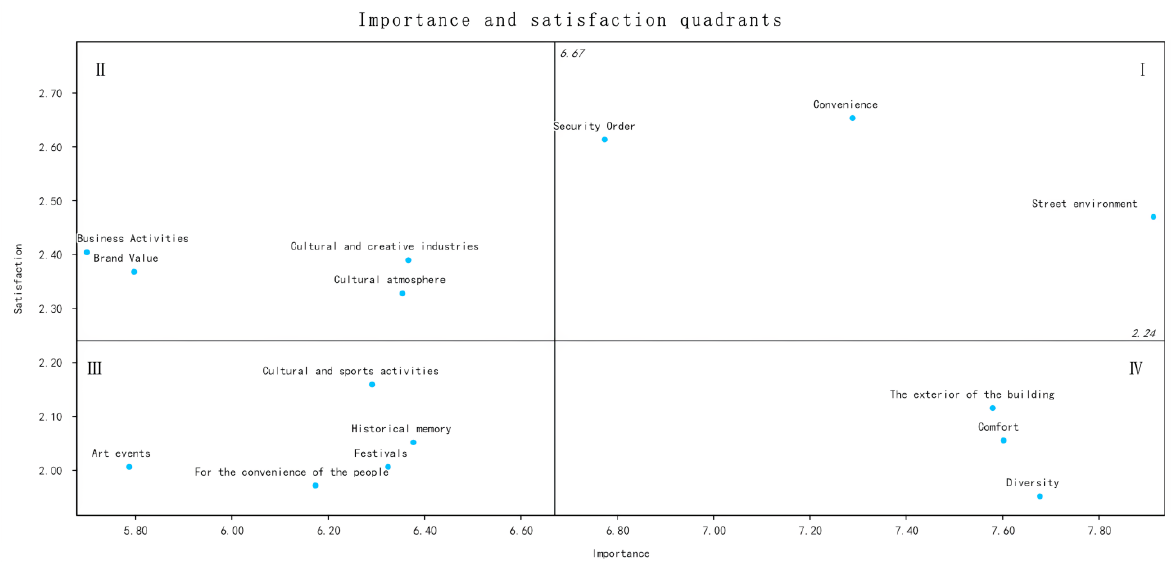
Figure 10. The result of AHP.